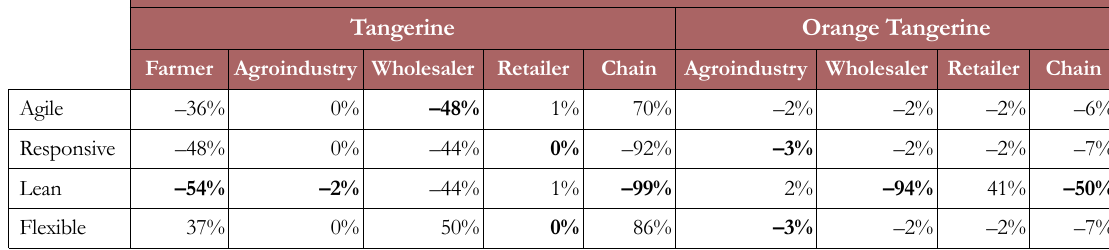
Table 7c. Percentage Change inventory for